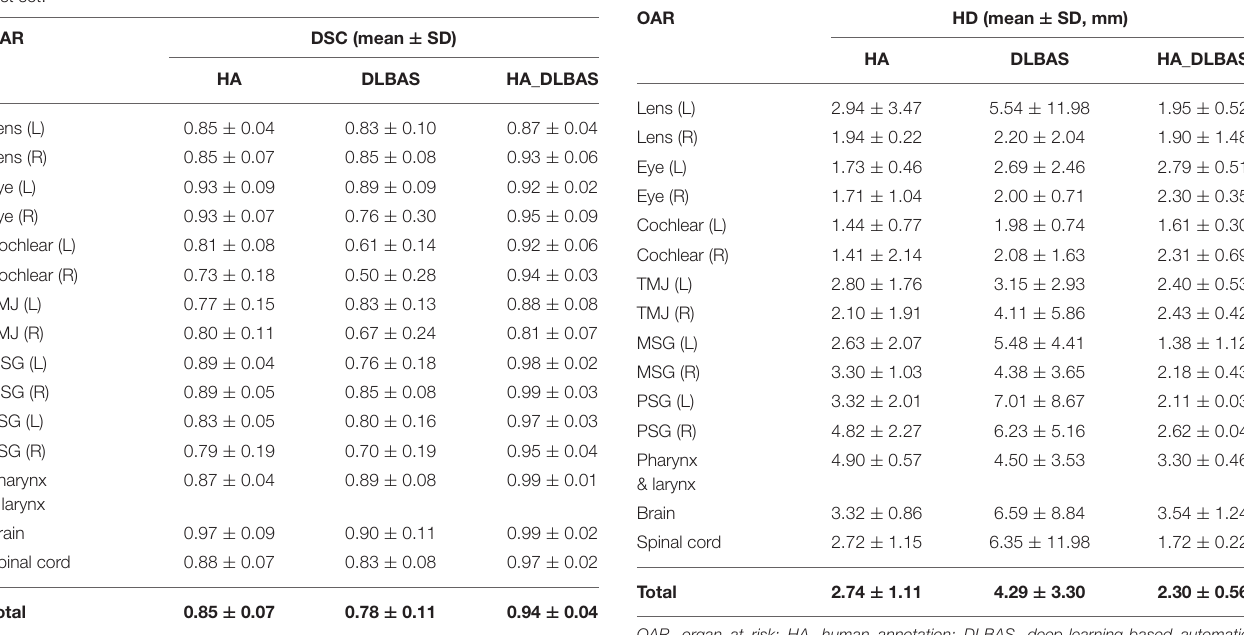
TABLE 6 | Hausdorff distance by three contouring methods of the clinical test set.